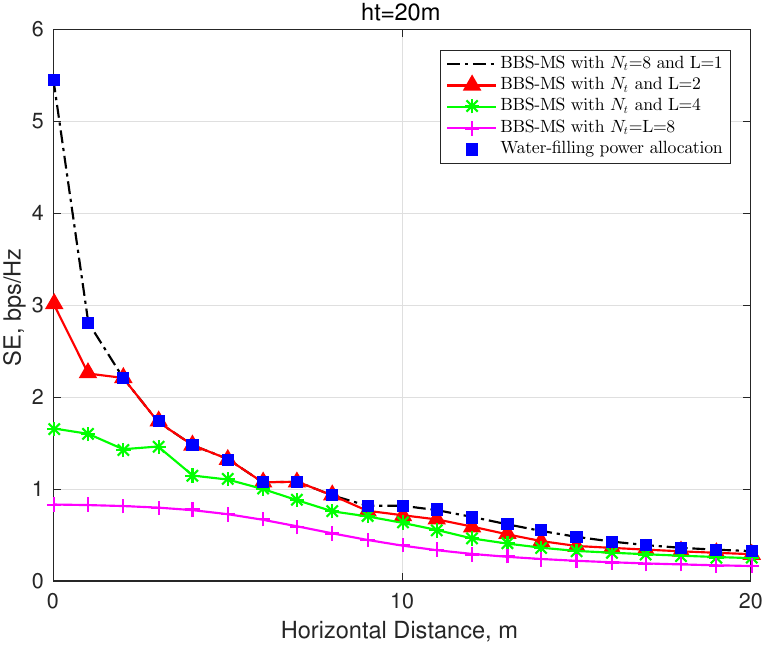
Figure 6. Spectrum efficiency, R = 20 λ and SNR = 20